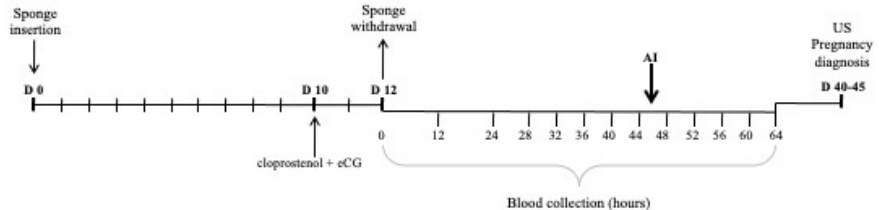
Figure 1. Scheme representing the blood sampling during the